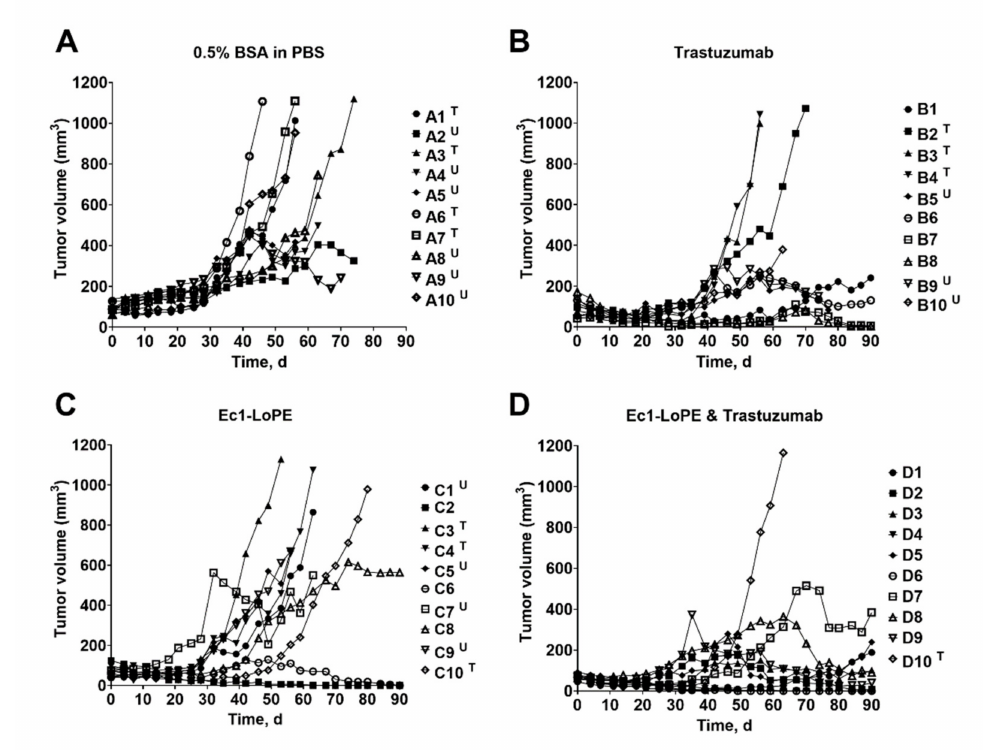
Figure 8. Tumor volume growth curves for individual mice from four groups receiving: subcu- taneous (s.c.) injection of vehicle (0.5% BSA in PBS) for six consecutive weeks ( A ), s.c. injection of trastuzumab ( B ), intravenous (i.v.) injection of Ec1-LoPE ( C ), and s.c. injection of trastuzumab together with i.v. injection of Ec1-LoPE ( D ). The doses and frequency of trastuzumab injections were 8 mg/kg for the first two weeks and 4 mg/kg for the next four consecutive weeks. The injections of Ec1-LoPE (1 mg/kg) were carried out at days 0, 2, 4, 7, 35, 37, 39, 42. Mice were euthanized when xenograft volume exceeded 1000 mm 3 (T) or bleeding ulcers were observed (U). Four groups of mice (10 animals per group) were used in the